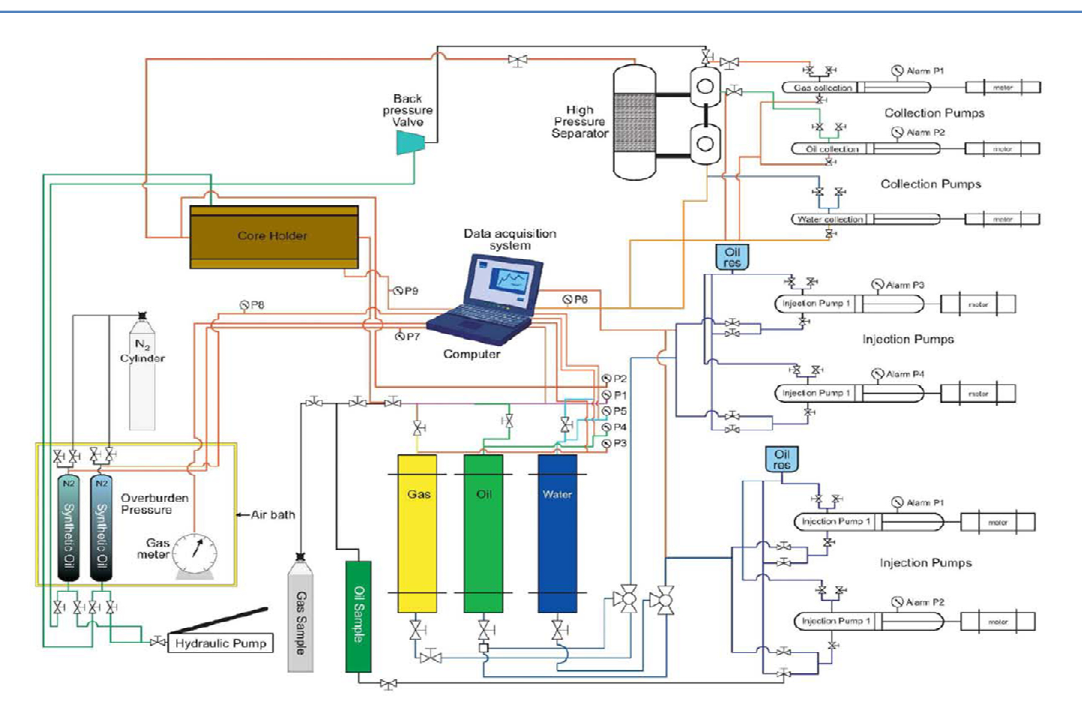
Figure 7. A schematic diagram of a core flood system.